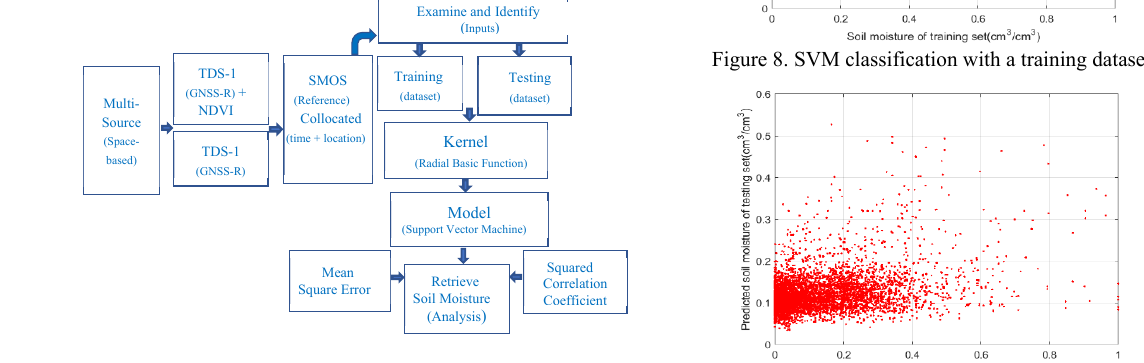
Figure 7. Data Processing Flow of Retrieving Soil Moisture